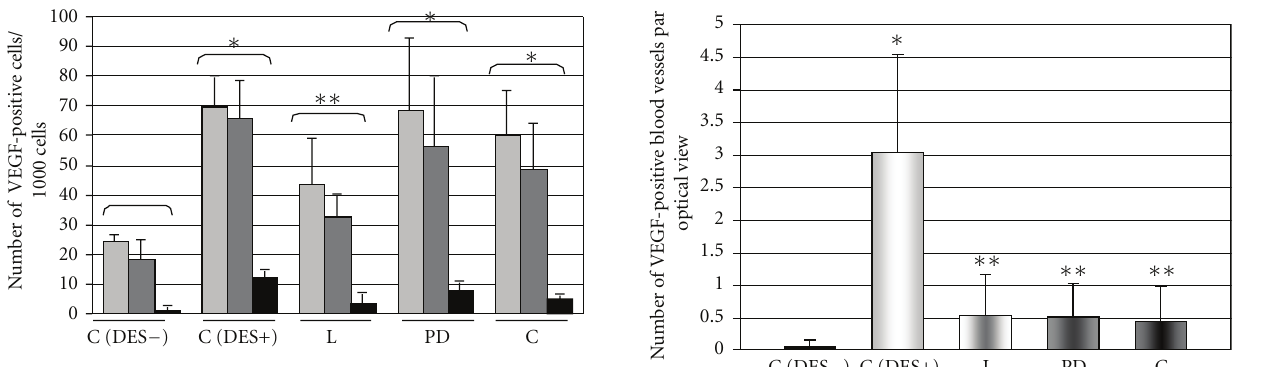
Figure 4: The influence of AT1 receptor antagonist losartan (L), AT2 receptor antagonist PD123319 (PD) and ACE inhibitor capto- pril (C) on diethylstilboestrol- (DES-) induced increase in number of VEGF immunopositive blood vessels in anterior pituitary of rats. X ± SEM; ∗ P < 0 . 05 versus C (DES − , control DES-untreated group), ∗∗ P < 0 . 05 versus C (DES+, control DES-treated